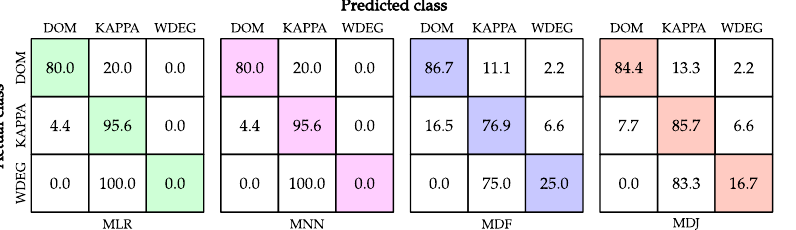
Figure 5. Confusion matrices for the classifiers within the Machine-Learning-based algorithm selectors on the test